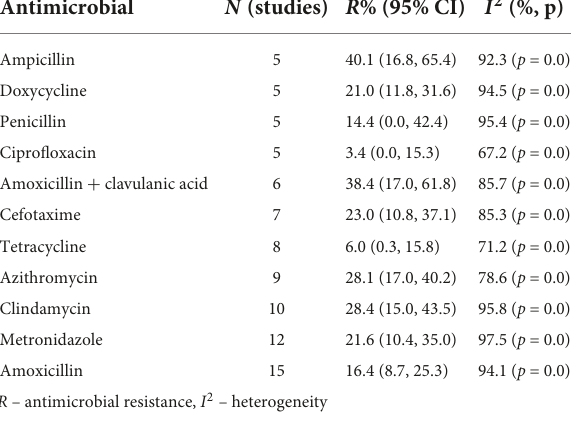
TABLE 1 Antimicrobial resistance reported in periodontal diseases according to the studies.